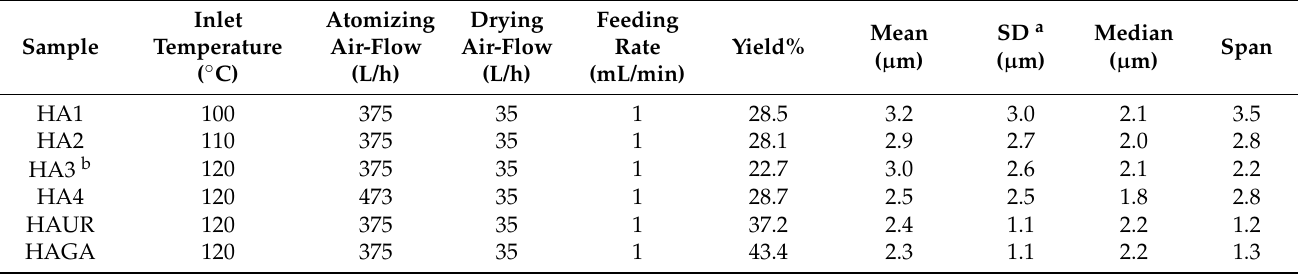
Table 1. Process conditions of spray drying and particle size analysis of HA microparticles along with the crosslinked HA microparticles.